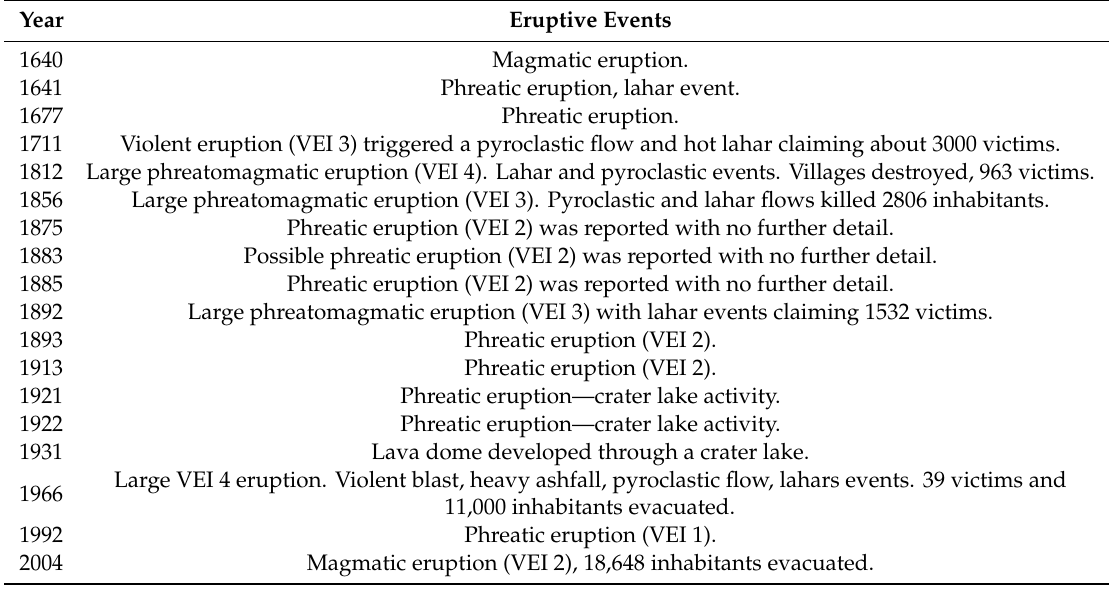
Figure 1. Awu volcano constitutes the northern portion of Sangihe Island ( A ) in the northern part of Molucca Sea, northeast Indonesia ( B ). The geodynamic context at the Molucca Sea is dominated by the double subduction of the same Molucca Sea plate that deepens to the east under the Halmahera arc, and to the west under the Sangihe arc, as materialized by the depth of seismic events ( C ). The high number of located earthquakes in the middle of Molucca Sea emphasizes the current ongoing arc–arc collision, highlighted by the Sangihe forearc overriding the Halmahera forearc ( D ). Table 1. History of Awu eruptive